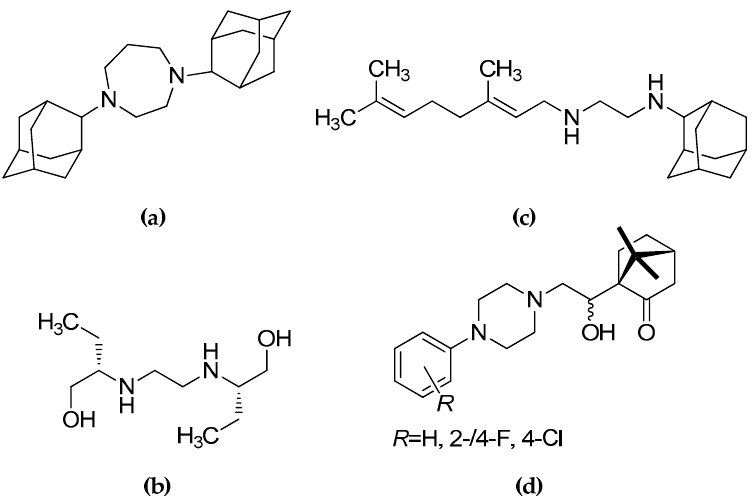
Figure 1. Chemical structures of: ( a ) compound SQ775 ; ( b ) ethambutol (EMB); ( c ) N -geranyl- N ´- (2-adamanthan-1-yl)ethane-1,2-diamine; and ( d ) chiral N -arylpiperazine-based aminoalcohols